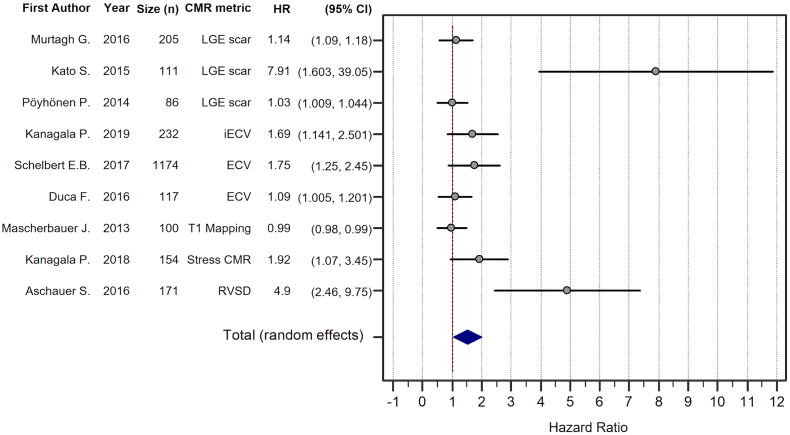
Forest plot of pooled hazard ratio (HR) for all the studies with weighted random-effects model HR (1.518, 95% CI 1.05 to 1.99) in favour of cardiac MRI assessment for prognostication of HFpEF patients.